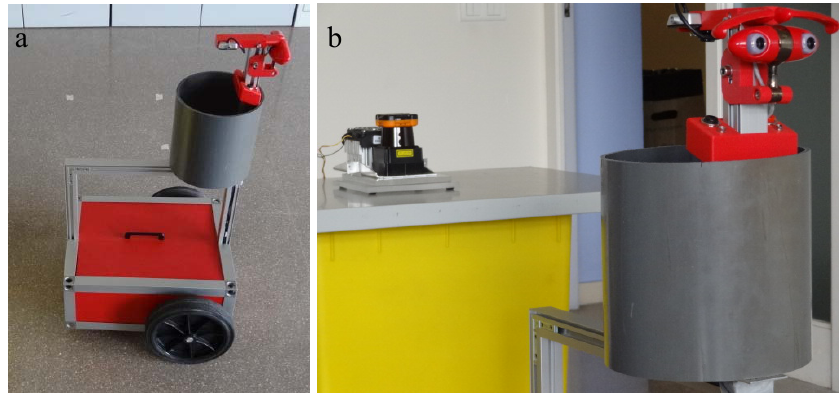
Figure 15. Images of the mobile robot with a circular marker attached ( a ) and the laser scanner ( b